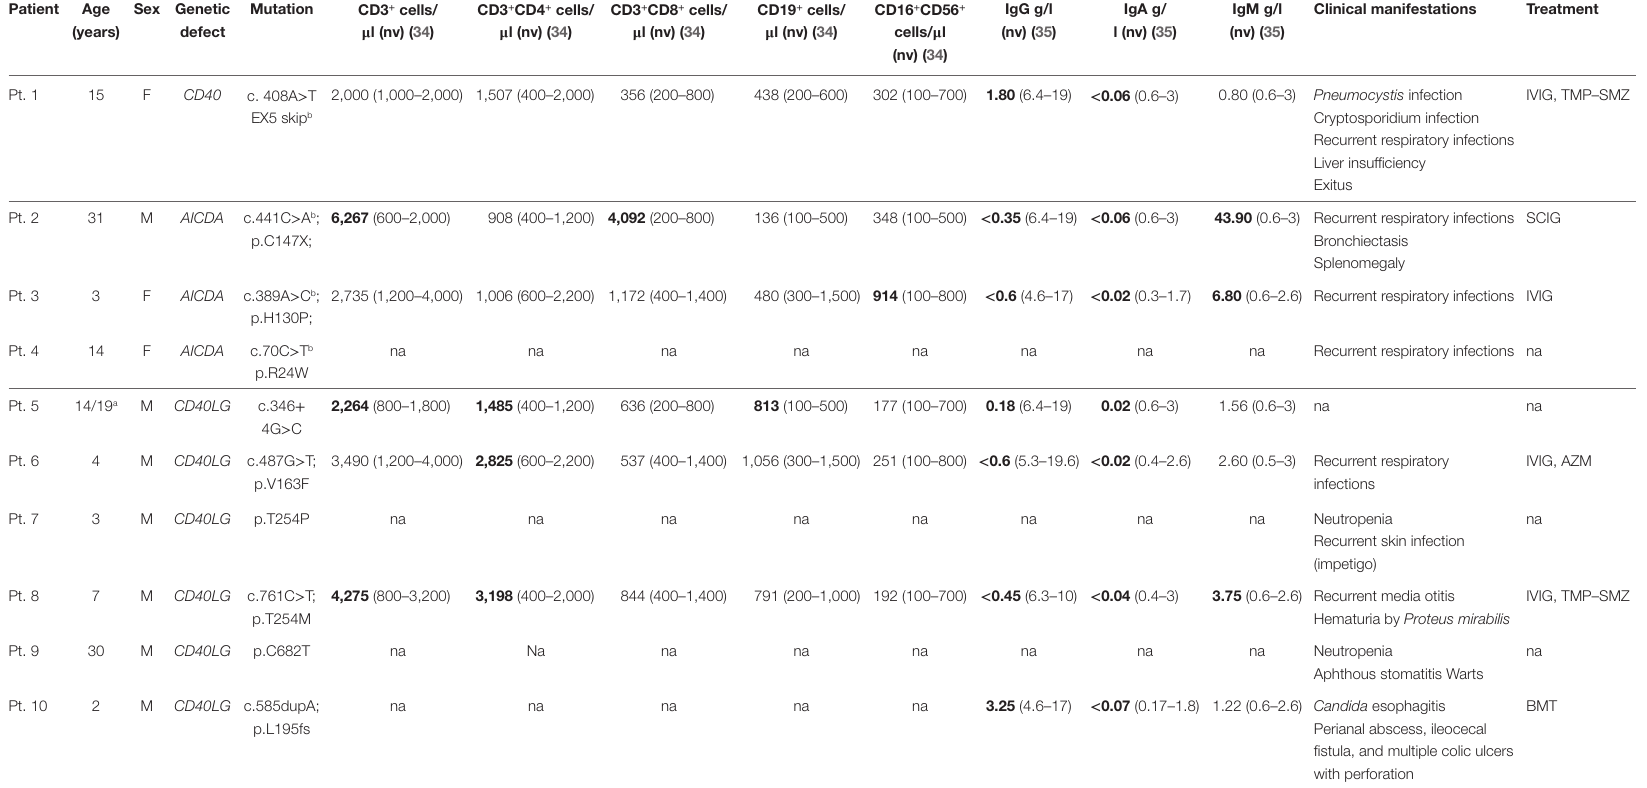
taBLe 1 | Patients’ mutations, clinical characteristics and immunological profile. patient age sex Genetic (years) defect